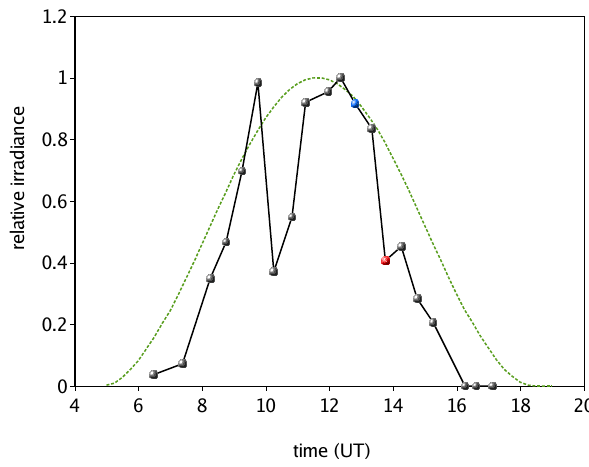
Fig. 5. Comparison of the Brewer#178 and Cimel AOD values at 320nm. The red line is the linear regression curve ( f (x) = 0 . 863 x + 0 . 025) of the